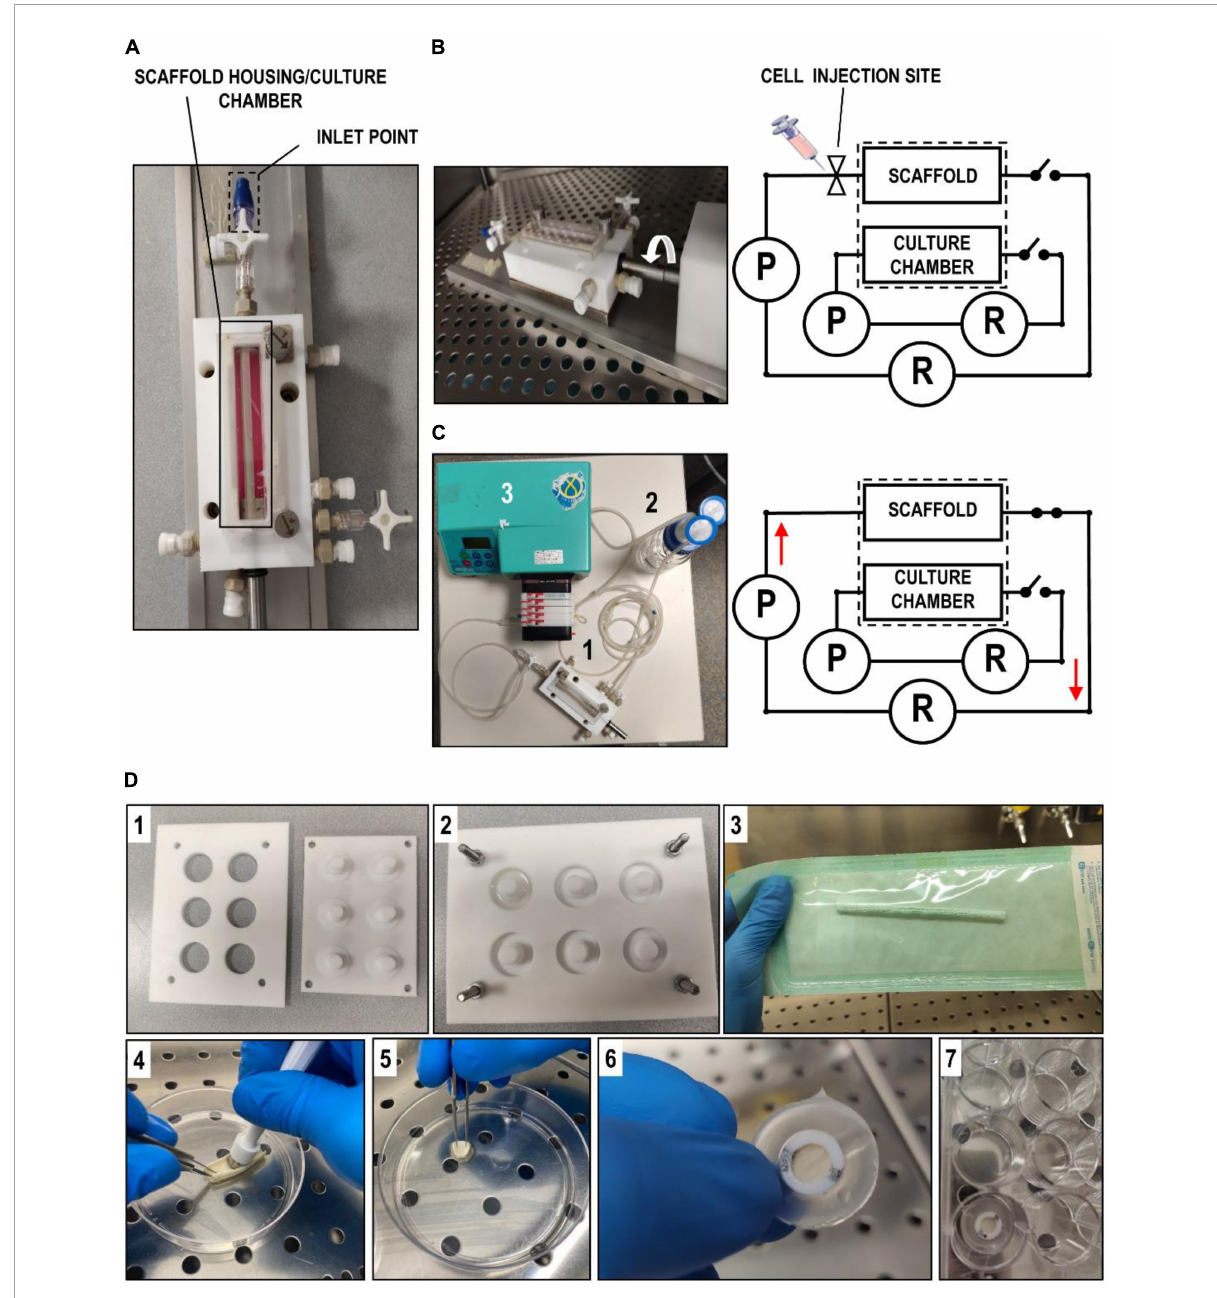
FIGURE1 Illustration of bioreactors and scaffolds derivation. (A) Overall hydraulic scheme of the Minibreath bioreactor. It is shown the compartment used for scaffold housing and the inlet point where cells were injected to proceed with seeding. (B) The picture on the left and the scheme on the right show, respectively, an illustration of the rotating seeding phase and the configuration of the bioreactor. P indicates the peristaltic pump and R the medium reservoir. During the seeding phase, cell suspension was injected inside the luminal compartment of the scaffold after which, the system was allowed to rotate the scaffold for a period of 3 days. (C) After 3 days of seeding phase, the scaffold was perfused with a physiological venous flow (0.5 mL/min) provided by a closed loop hydraulic circuit (scheme on the right), consisting of tubing (1), a reservoir (2) and a peristaltic pump (3). (D) Description of the tools and the procedure employed to optimize the seeding of the silk scaffolds. Panels 1 and 2 show, respectively, the molds used to fabricate the PDMS holders used to house the circular silk patches in cell culture, while panel 3 shows one of the tubular scaffolds still in its sterile packaging. Panels 4–7 contain a sequence of pictures illustrating how we derived circular patchs from a tubular scaffold and placed them in a multiwell culture plate after housing into the PDMS mold. Static cell seeding and culture experiments were performed by gently pipetting ECs suspension over pre-wetted